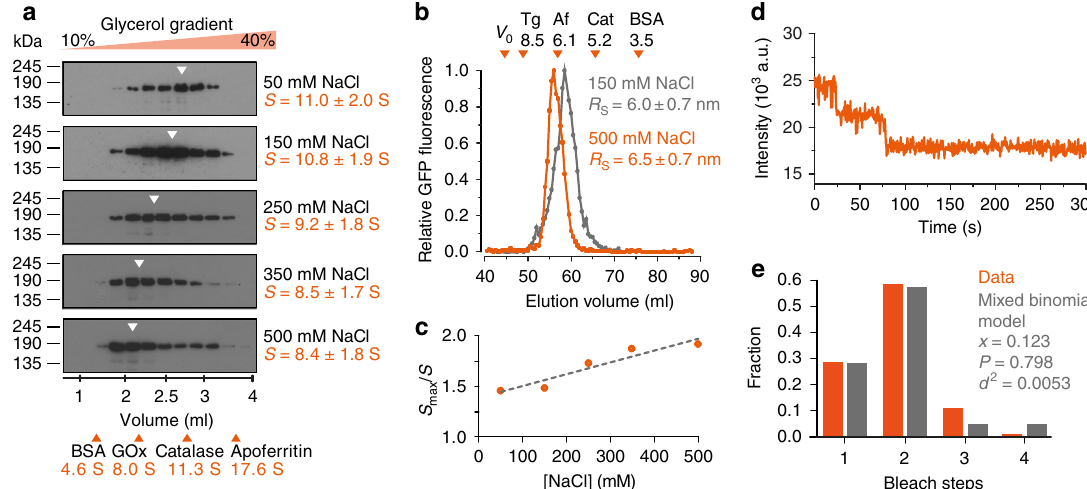
Fig. 1 KIF1C is a dimer. a Fractions from glycerol gradients of KIF1C-GFP at different salt concentrations as indicated. Elution peaks of standard proteins are indicated with orange arrowheads. GOx, glucose oxidase. Errors are SEM. Uncropped gels are provided in Source Data fi le. b Size exclusion chromatography of KIF1C-GFP at 150 mM NaCl (grey) and 500 mM NaCl (orange). Elution peaks of standard proteins (Tg thyroglobulin, Af apoferritin, Cat catalase, BSA bovine serum albumin) and void volume V 0 are indicated by orange arrowheads. Errors are SEM. c Frictional coef fi cient of KIF1C-GFP at different salt concentrations indicating that KIF1C elongates with increasing ionic strength. d , e Bleach curve of KIF1C-GFP on microtubules showing discrete steps in fl uorescent decay in d . Experimentally determined bleach steps are shown in e together with best fi t to a mixed binomial model of dimers and tetramers with x being the fraction of tetramer and p the fraction of active GFP molecules. n = 108 motors. Data are provided in Source Data fi